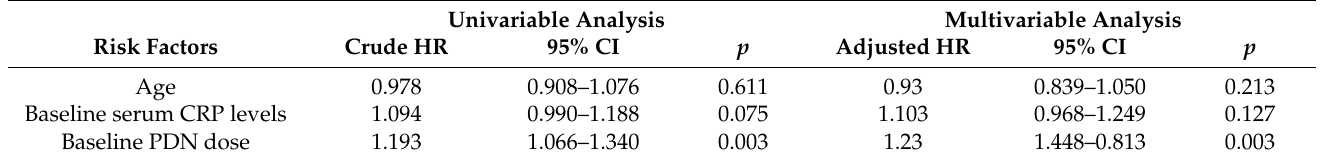
Table 4. Prognostic factors of death from PCP in patients with RA. Univariable Analysis Multivariable Analysis